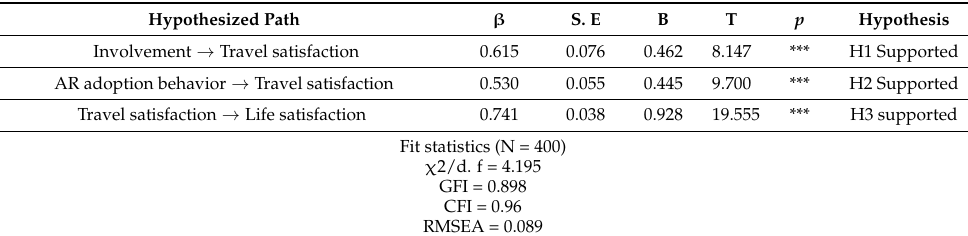
Table 5. Structural parameter estimates and good-of-fit indices for total